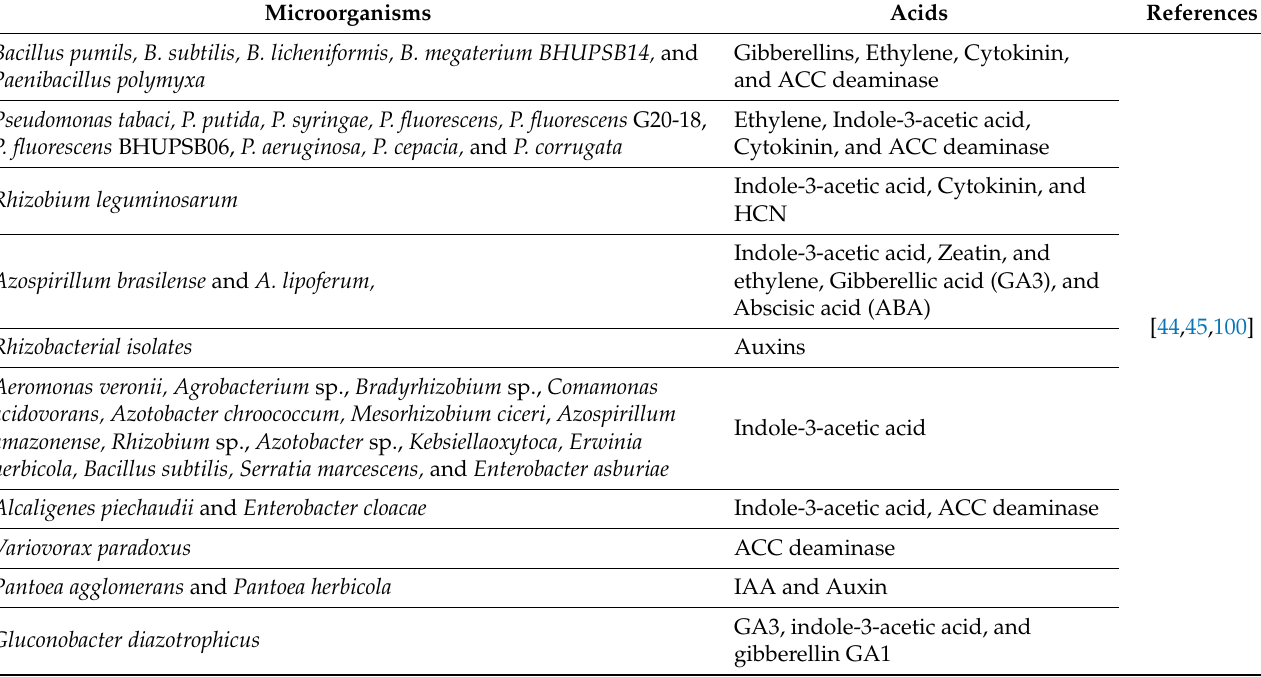
Table 3. Plant growth promoting substance (acids) producing